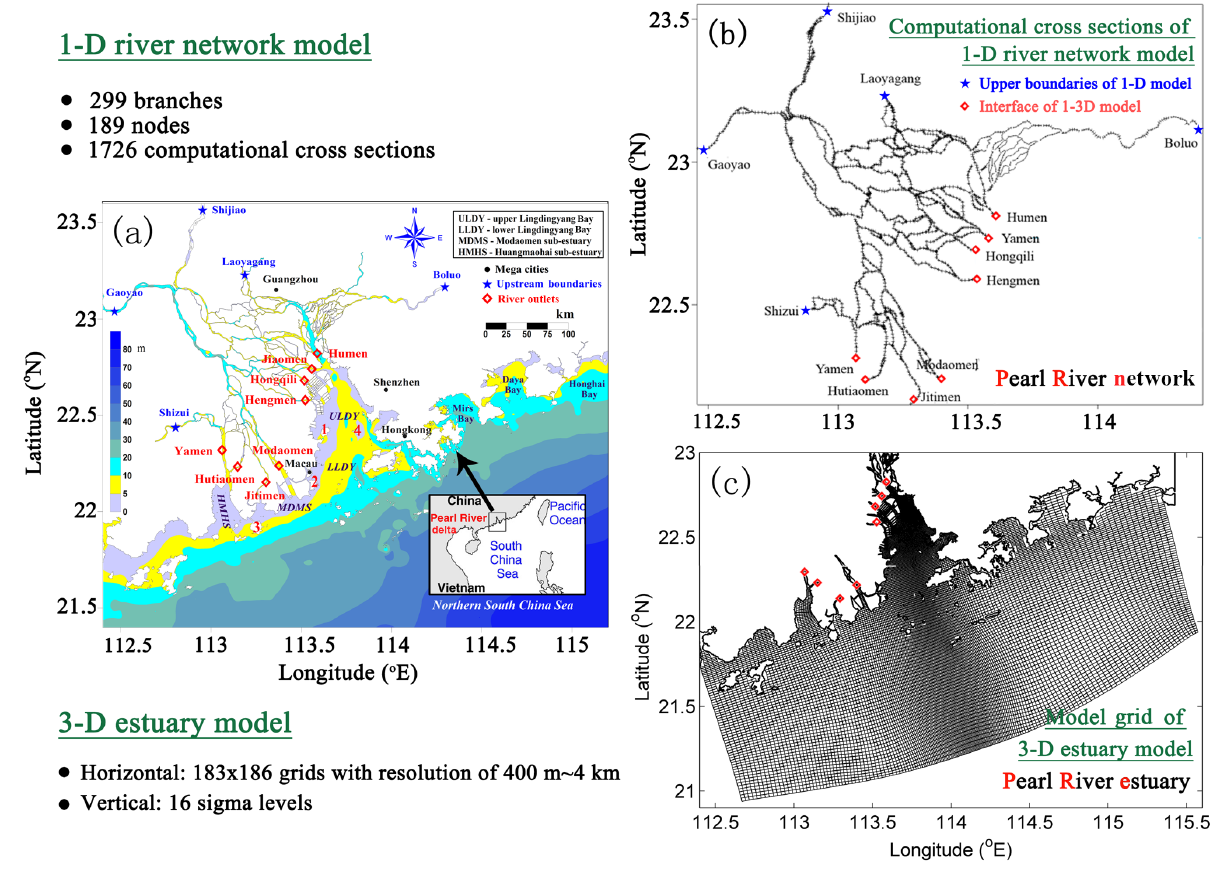
Figure 1. (a) A bathymetric map showing the Pearl River network and the Pearl River estuary, (b) computational cross sections for the 1-D river network model, and (c) the model grid for 3-D estuary model. Red numbers in (a) represent islands which are not marked on the map: 1 is Qi’ao Island, 2 is Hengqin island, 3 is Gaolan Island, and 4 is Inner Lingding